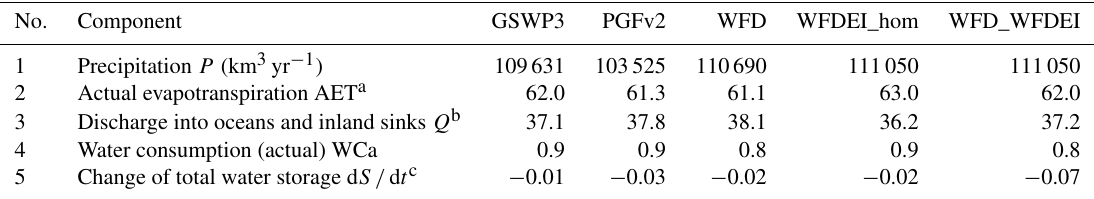
Figure 2. Continental water balance components 1971–2000 (km 3 yr − 1 ); ensemble mean of the five climate forcings. Abbreviations: actual evapotranspiration (AET), discharge into oceans and inland sinks ( Q ), actual water consumption (WCa). Table 2. Global water balance components for land area (except Antarctica and Greenland) in % of precipitation (row 1) for the five model variants and 1971–2000. Cells representing inland sinks were excluded but discharge into inland sinks was